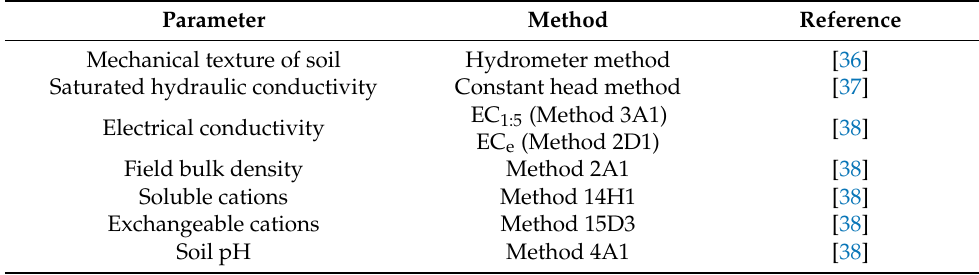
Table 1. Soil and water analysis method.